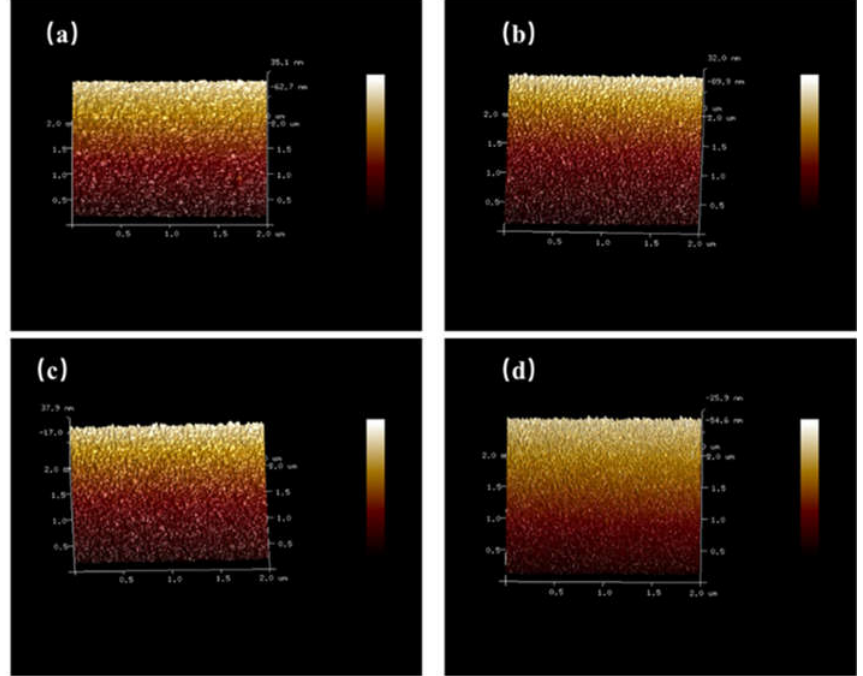
Figure 2. AFM images of Ga 2 O 3 films with various O 2 flow rates (5 × 5 µm 2 ). (a). 0sccm; ( b ). 1sccm; ( c ). 2 sccm; ( d ). 4sccm.